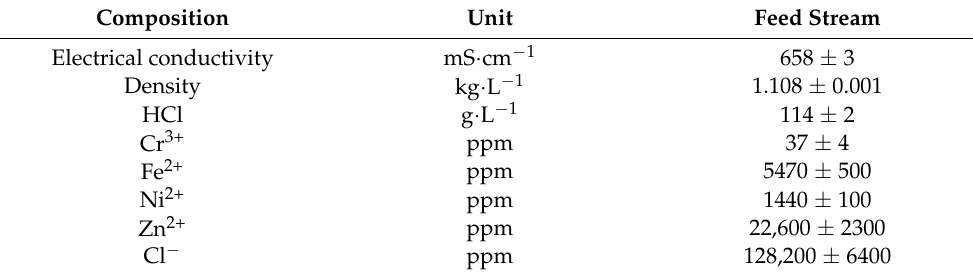
Table 8. Composition of the feed sample.